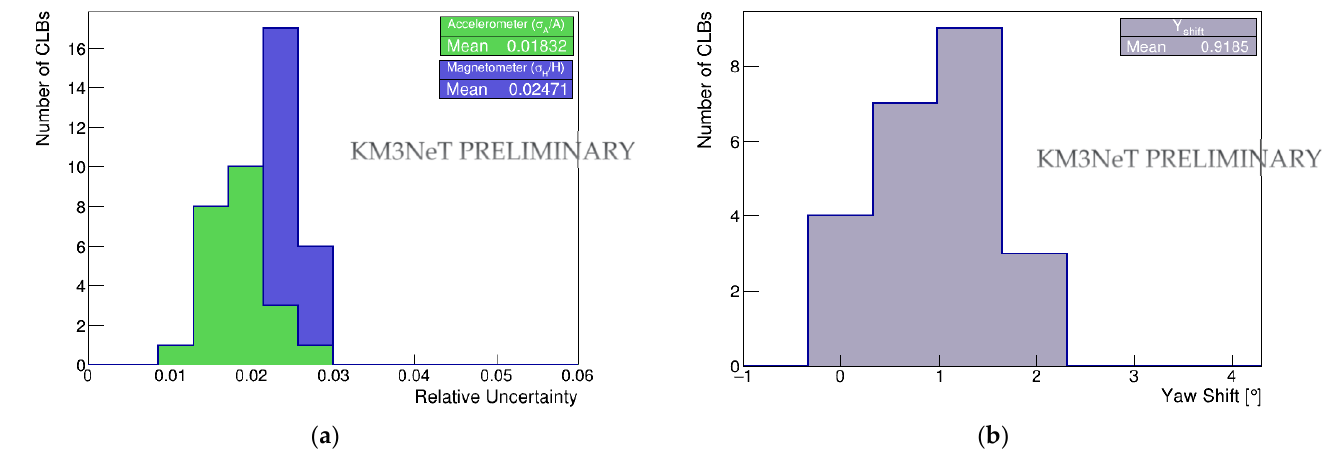
Figure 2. Acceptance tests for CLBs in a recent Digital Compasses calibration: ( a ) accelerometer and magnetometer relative uncertainties; ( b ) Yaw shift.